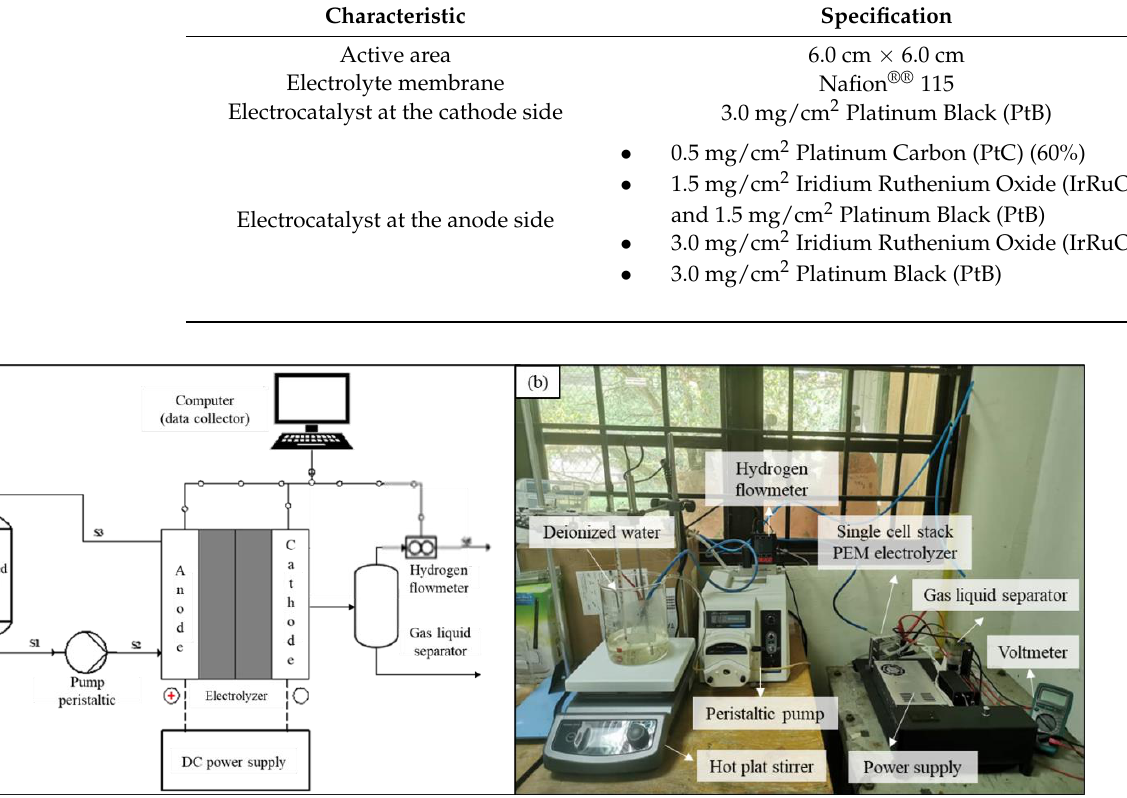
Figure 1. Components of a single-cell stack electrolyzer. Table 1. MEA Specifications.